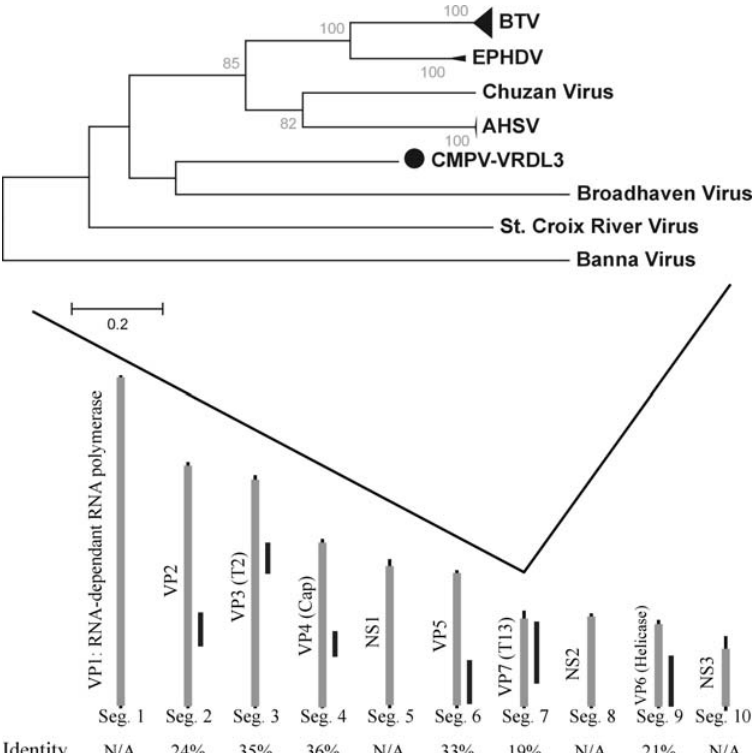
Figure 5. Novel Orbivirus. Alignment of VRDL3 fragments identified to genomic segments of model orbivirus sequence with amino acid identity percentages (bottom). Orbivirus VP7 amino acid neighbor-joining phylogenetic tree with bootstrap values from 1000 pseudo-replicates